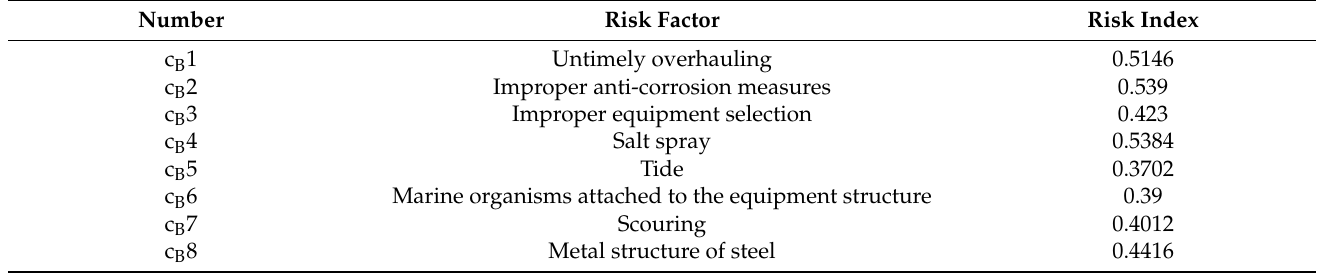
Table 2. Corrosion risk factors of offshore wind